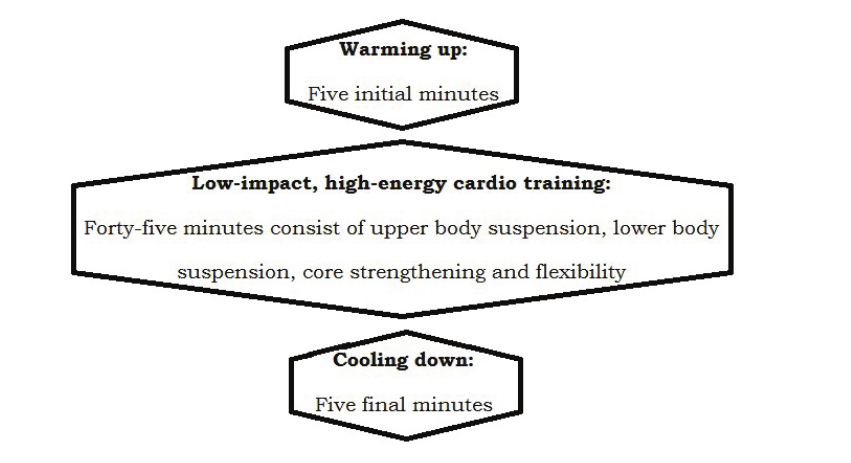
Figure 1. The organizational structure of the aquatic exercise program of